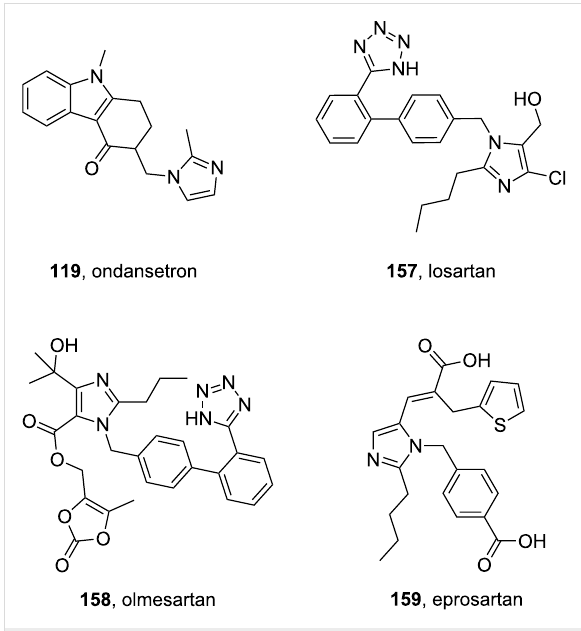
Figure 5: Structures of imidazole-containing